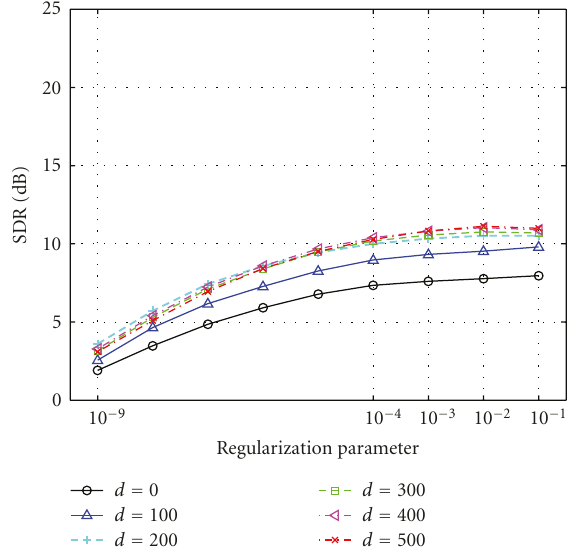
Figure 11: Performance as a function of the regularization param- eter and modeling delay (filter length is fixed at M =